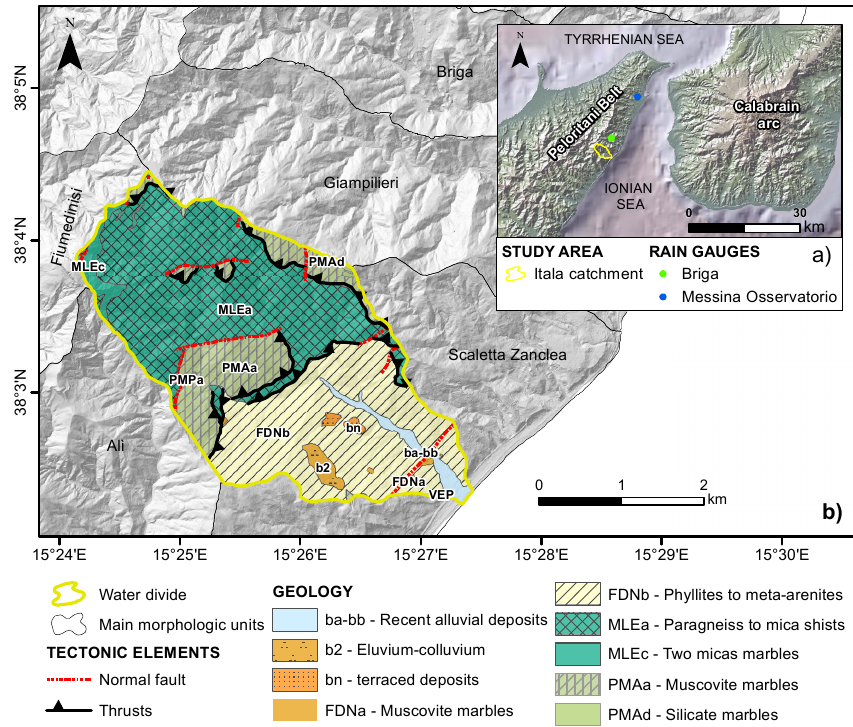
Figure 1. Study area: (a) geographical setting and rain gauge locations; (b)